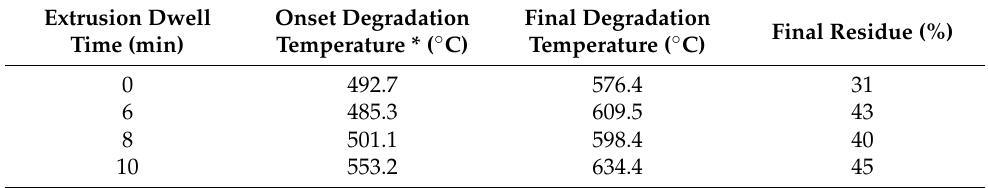
Table 6. Onset and final degradation temperatures for LLDPE/MP with extrusion dwell